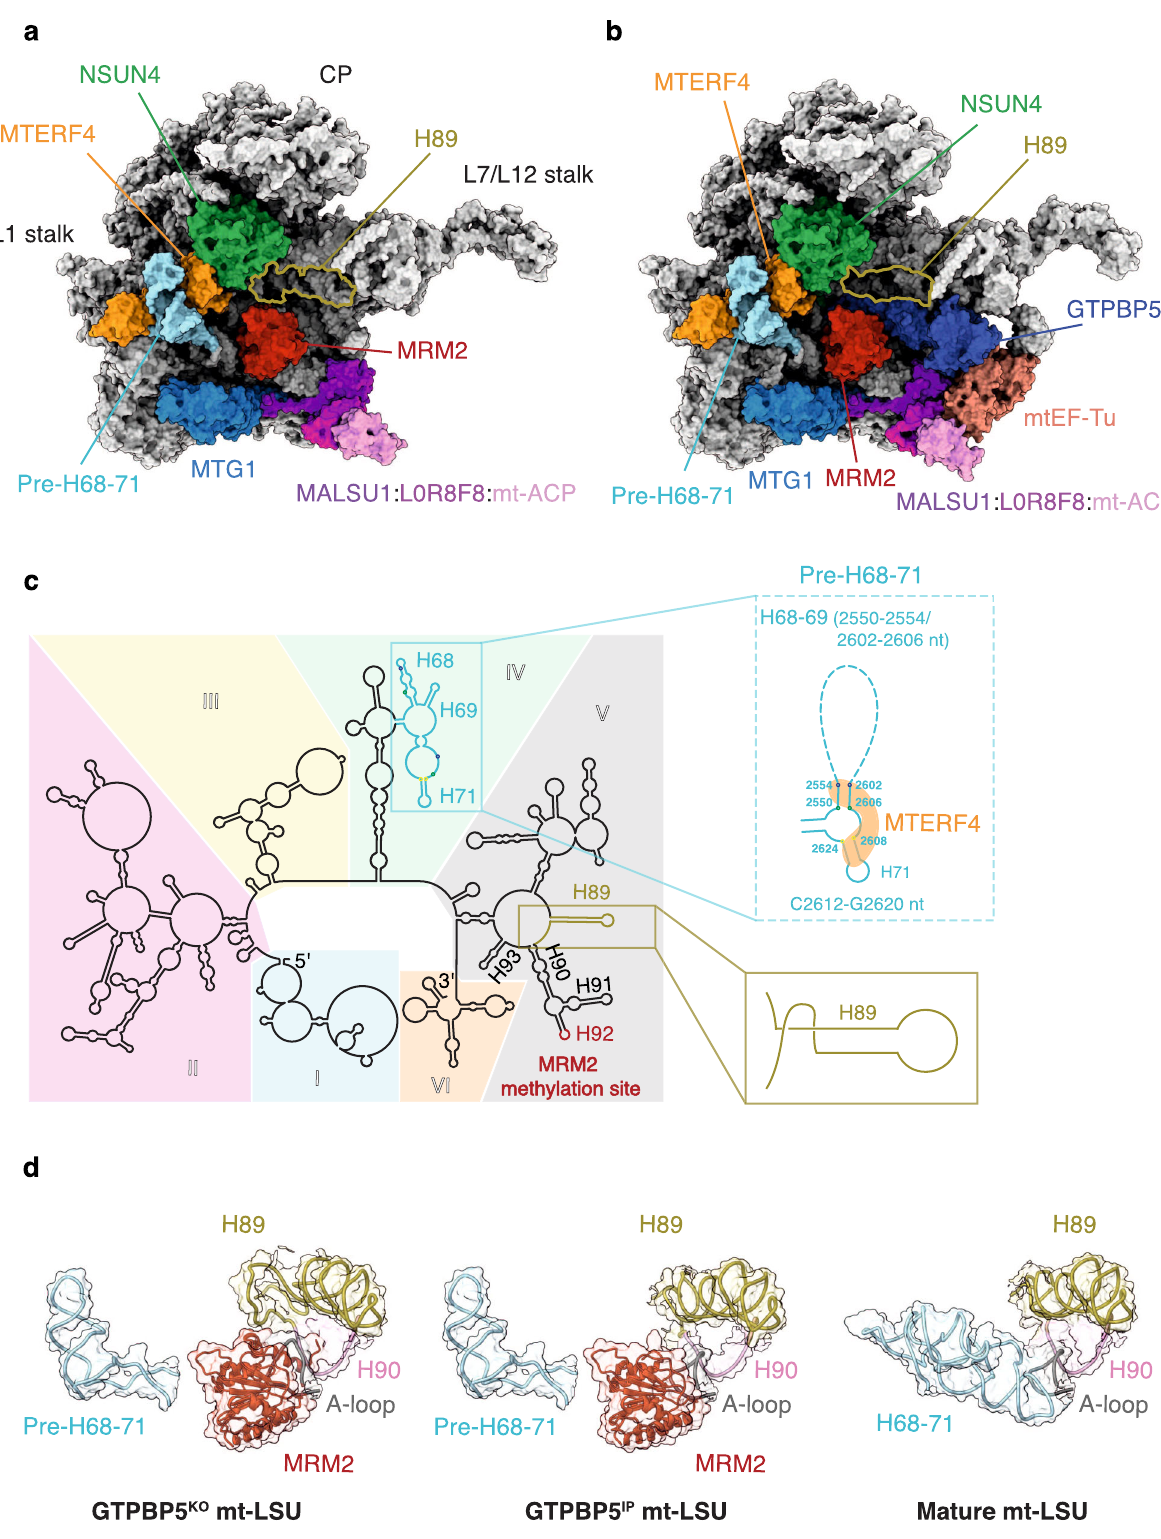
homologs contact the rRNA, reaching out toward the PTC (Supplementary Fig. 6c), in the trapped intermediates described here MTG1 is unlikely to induce pronounced conformational changes of the